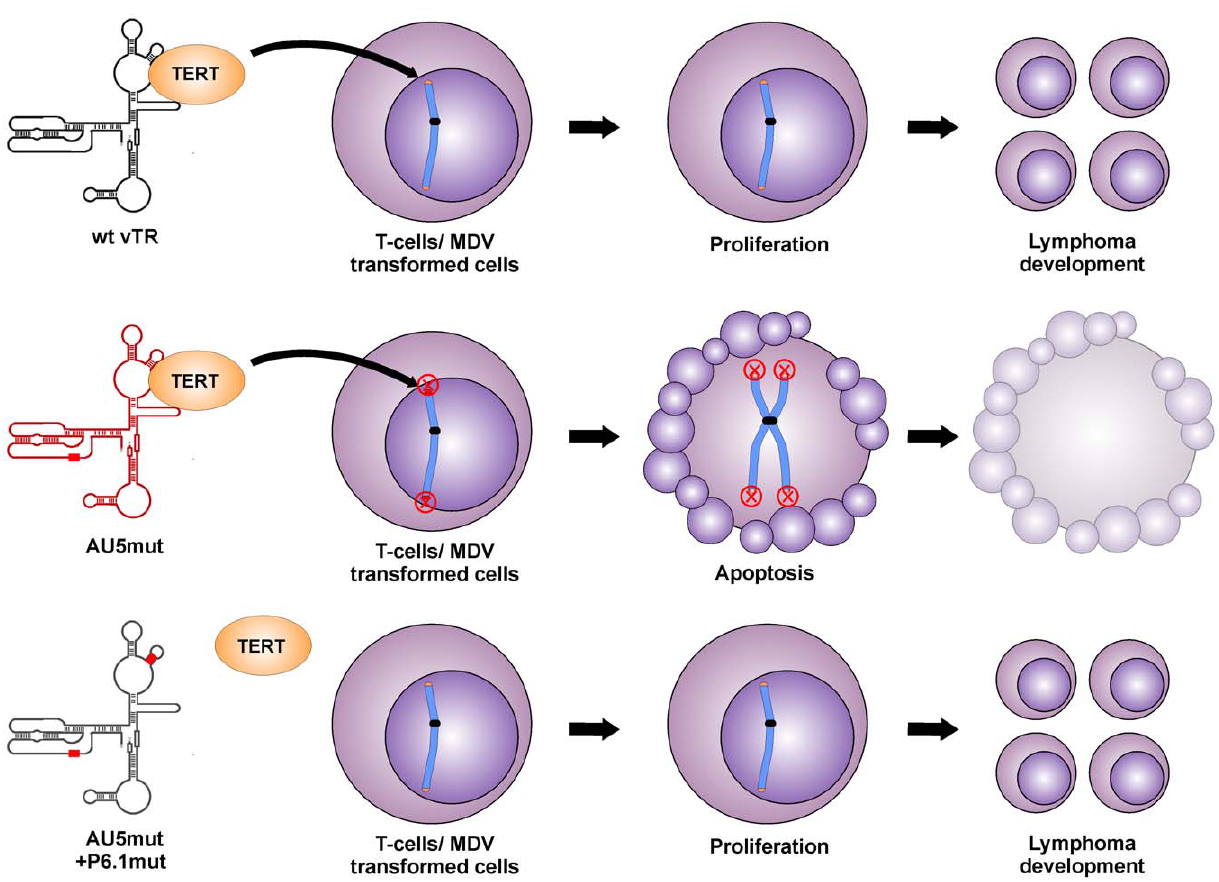
Figure 8. Proposed model for abrogation of tumor induction by mutant template sequence vTR through incorporation of mutant telomere sequences in transformed T cells. Expression of vTR AU5 leads to telomere instabilities, aberrant chromosome separation and segregation, and finally apoptosis induction in the presence of TERT (upper panel). Without vTR interaction with TERT by mutation of the P6.1 stem loop, mutant template sequences (AU5) are not incorporated in the telomeres of transformed cells and thus proliferation of transformed cells continues, leading to lymphomas.